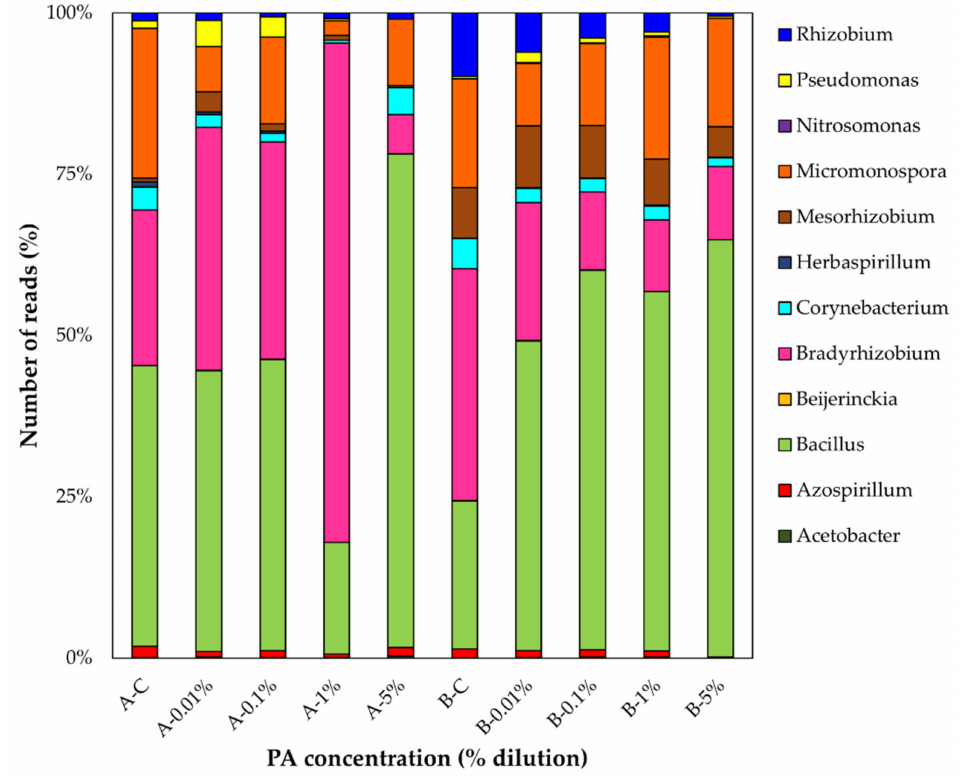
Figure 3. The relative abundance of the important plant growth-promoting rhizobacteria in Soil A and B spiked with different concentrations of PA (Control (C), 0.01%, 0.1%, 1%, and